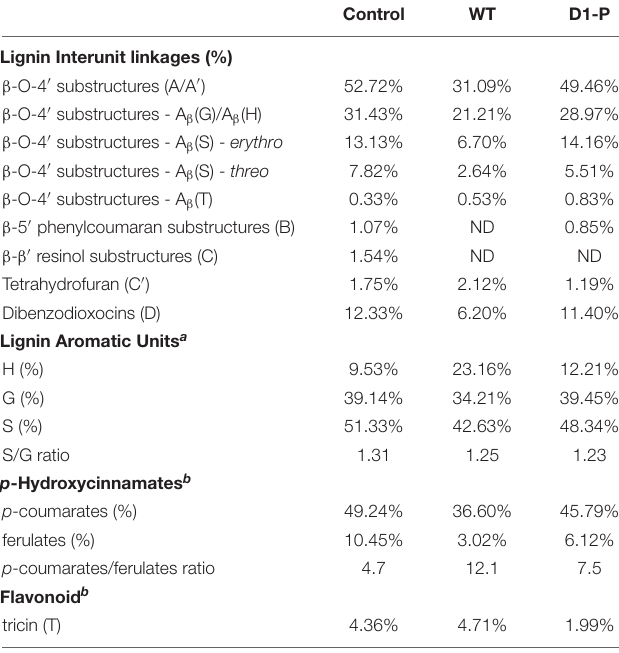
TABLE 4 | Structural characteristics (lignin interunit linkages, aromatic units, and S/G ratio, p-Coumarate/Ferulate, tricin) from integration of C-H correlation peaks in the HSQC spectra of the corn stalk after 1-month